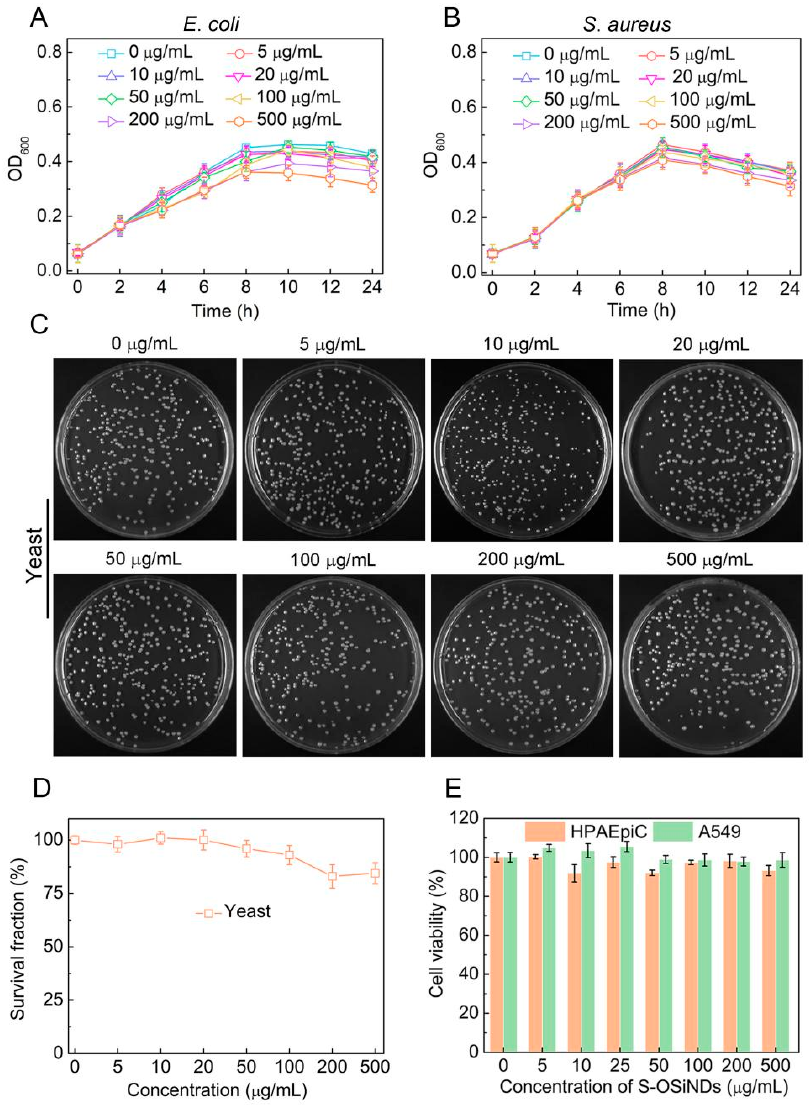
Figure 12. Cytotoxicity evaluation results of S-OSiNDs toward bacterial, fungal, and mammalian cells. Optical density at 600 nm (OD 600 ) values of ( A ) E . coli and ( B ) S . aureus bacterial suspensions treated with various concentrations of S-OSiNDs for different time periods. ( C ) Photographs of the agar plates showing the formed colonies of S . cerevisiae yeasts that were treated with various concentrations of S-OSiNDs for 24 h and ( D ) corresponding statistical data. ( E ) Relative viabilities of HPAEpiCs and A549 cells after treatment with different concentrations of S-OSiNDs for 24